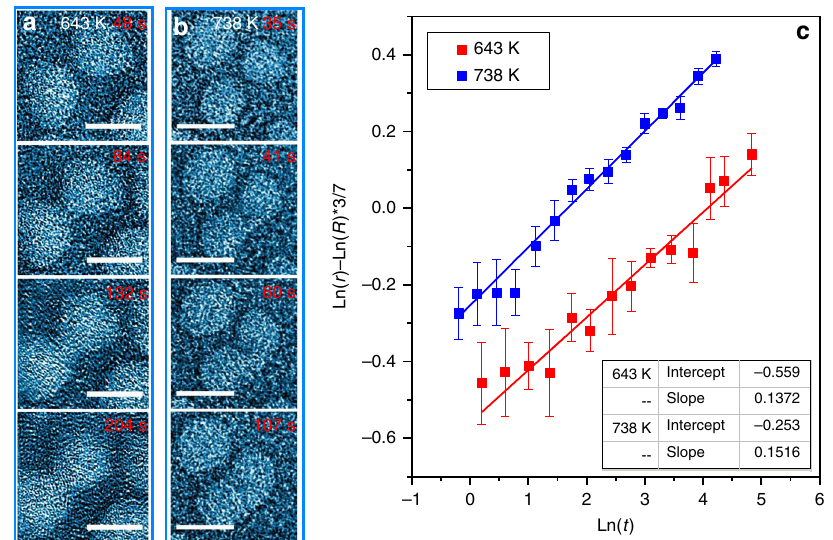
Fig. 3 Coalescence of amorphous PdSi particles at different temperatures. a , b Video images showing the coalescence of particles at 643 and 738 K, respectively. Scale bar: 5 nm. c The evolution of neck diameter as a function of time in logarithm. The data are fi tted using least-squares approximation, with the fi tted data shown in the inset table. Error bar represents standard deviation of 12 measurements of the neck width in corresponding